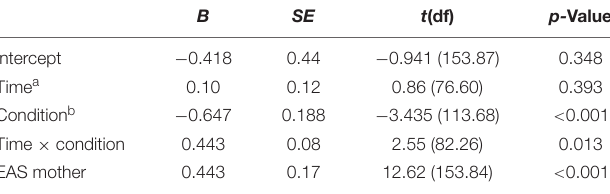
TABLE 4 | Coefficients of the best model selected (i.e., Model